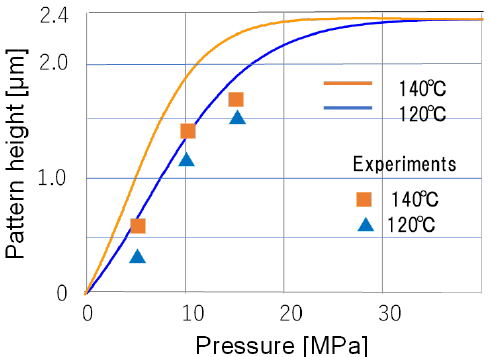
Figure 8. Prediction of pattern height with varying pressure by hybrid deep learning and experimental results. The nanoimprinting temperature was 120 °C and 140 °C and the glycerol concentration was 10%.